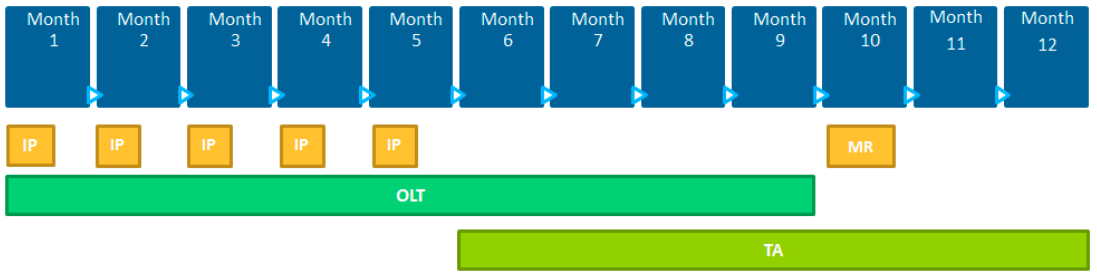
Figure 1. Structure and timing of Community Based Research Infrastructure to Better Science (CRIBS) training program. Notes: IP = in-person meetings; MR = in-person mock review of applications; OLT = online training and webinars; TA = telephone-based technical assistance.